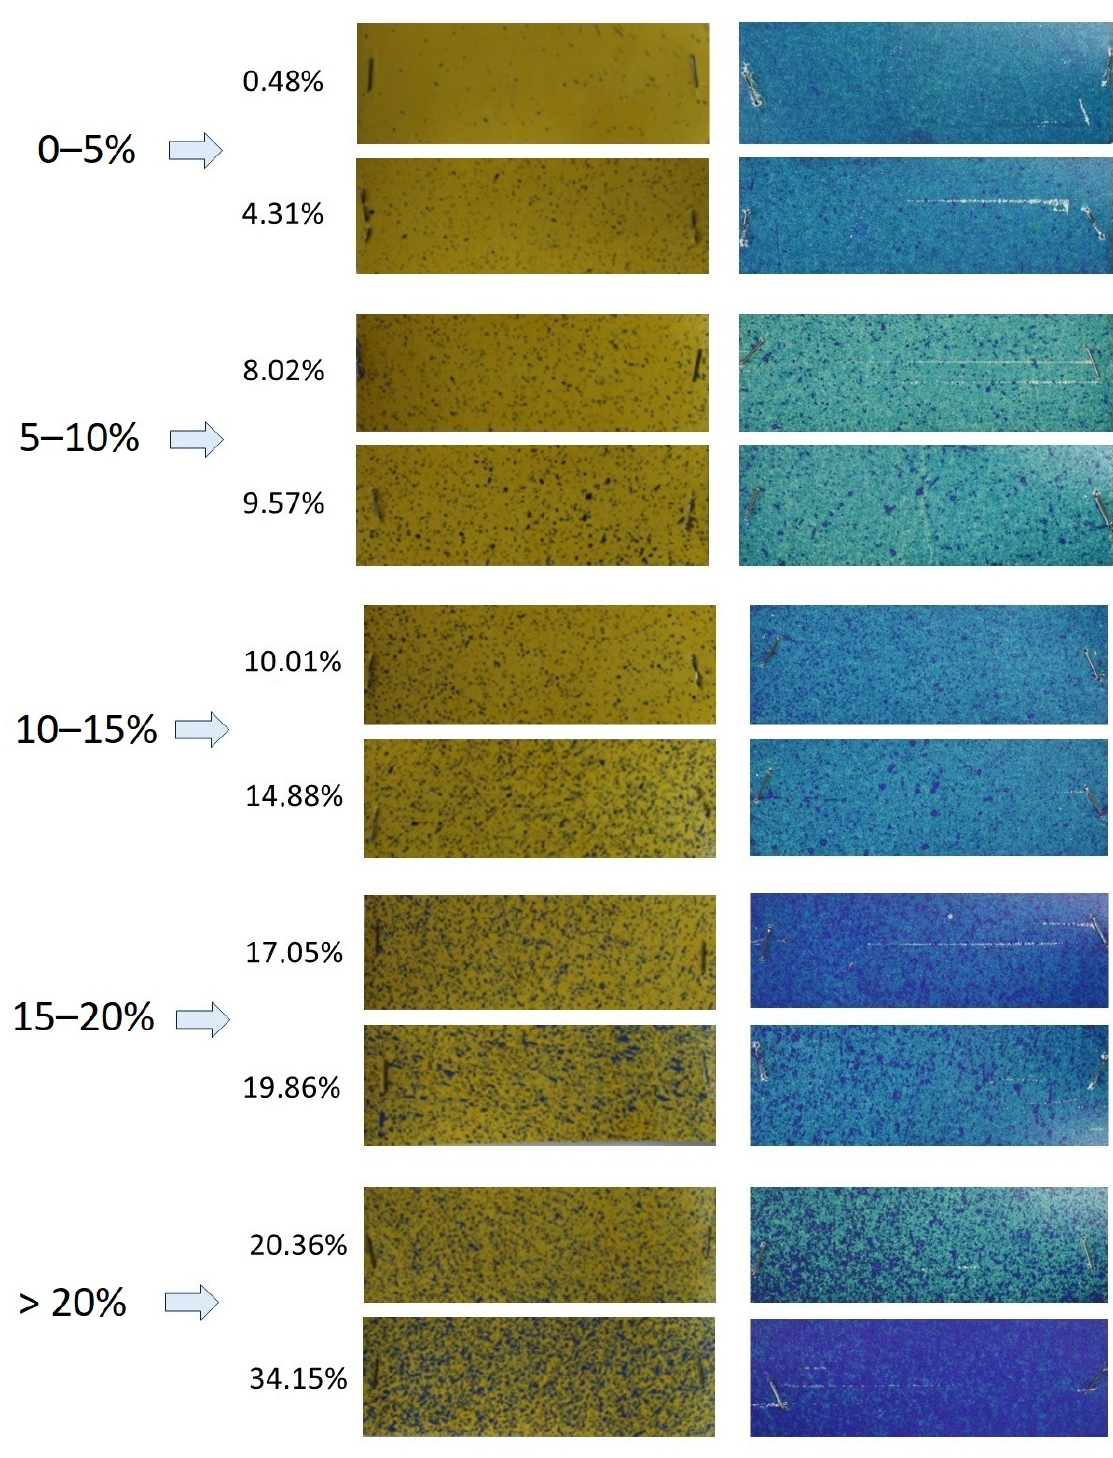
Figure 8. Example of comparisons between reference cards used in previous works ( on the left ) and water-sensitive papers used for the field trial on 29 October 2021 ( on the right ).